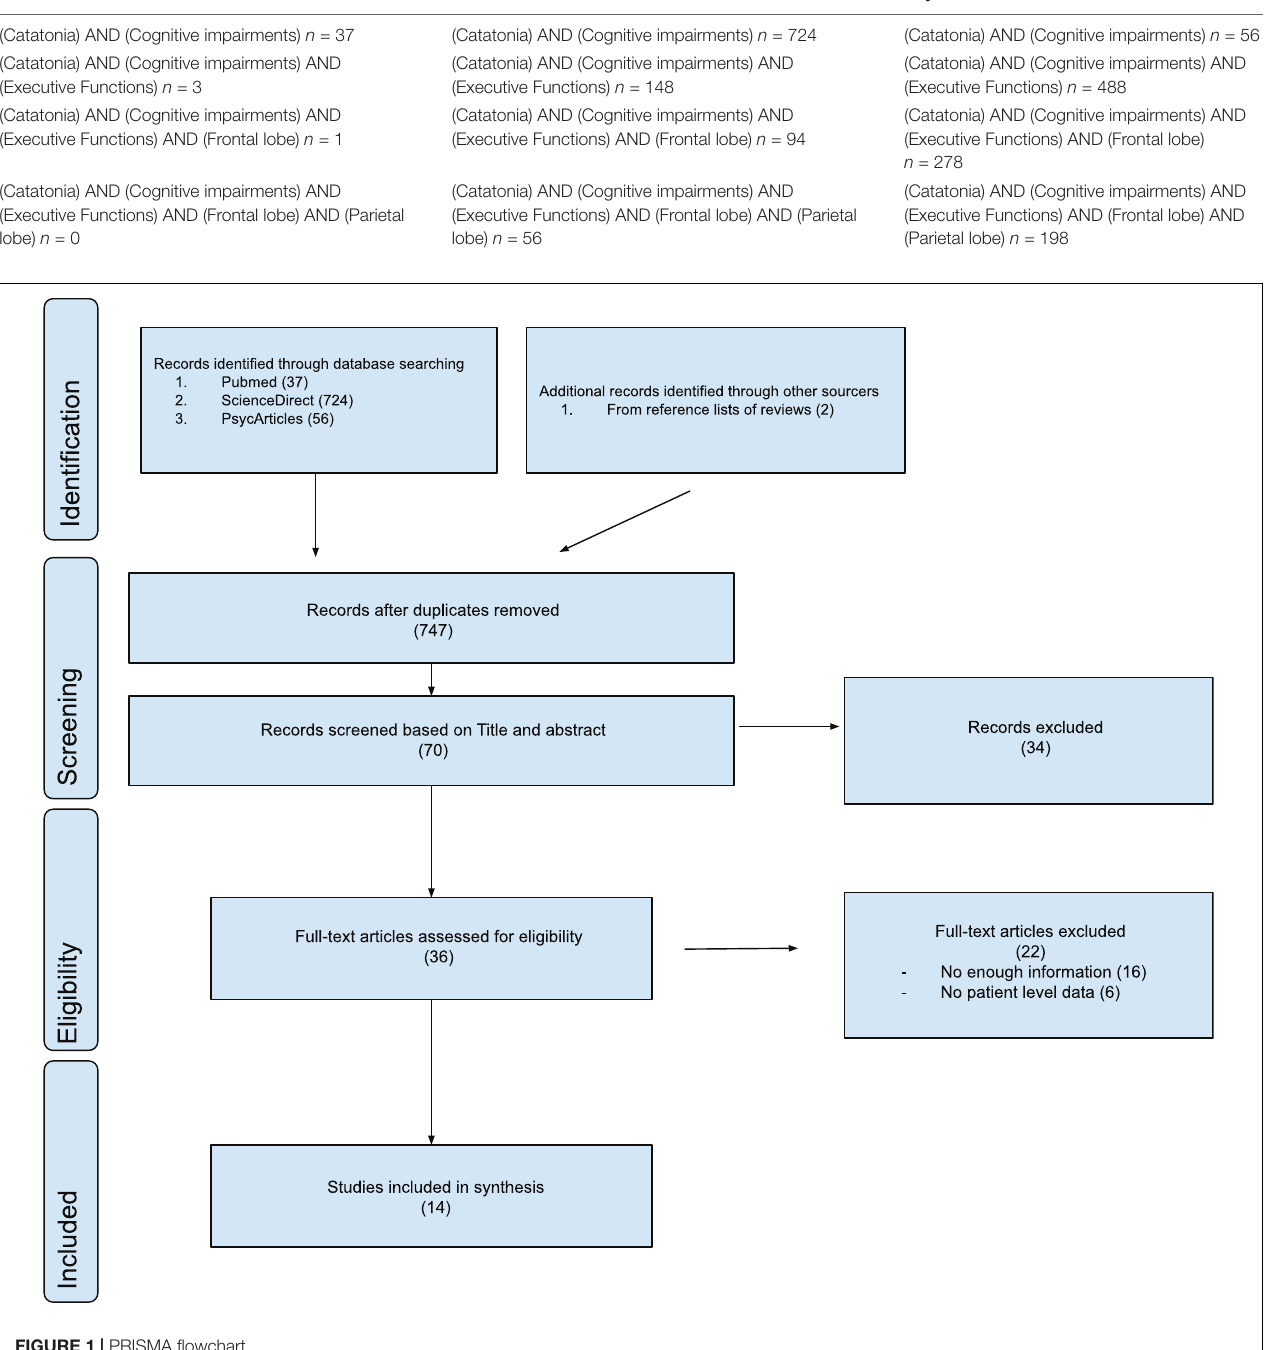
FIGURE 1 | PRISMA